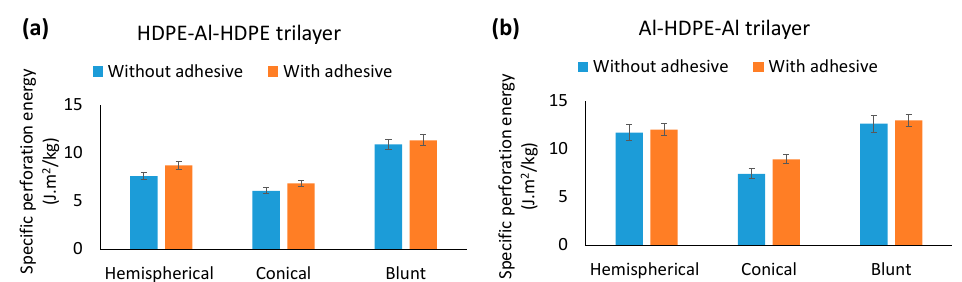
Figure 16. Comparison of perforation energy with and without adhesive for ( a ) when Al faced the indenter and ( b ) when HDPE faced the indenter in Al–HDPE bilayers.